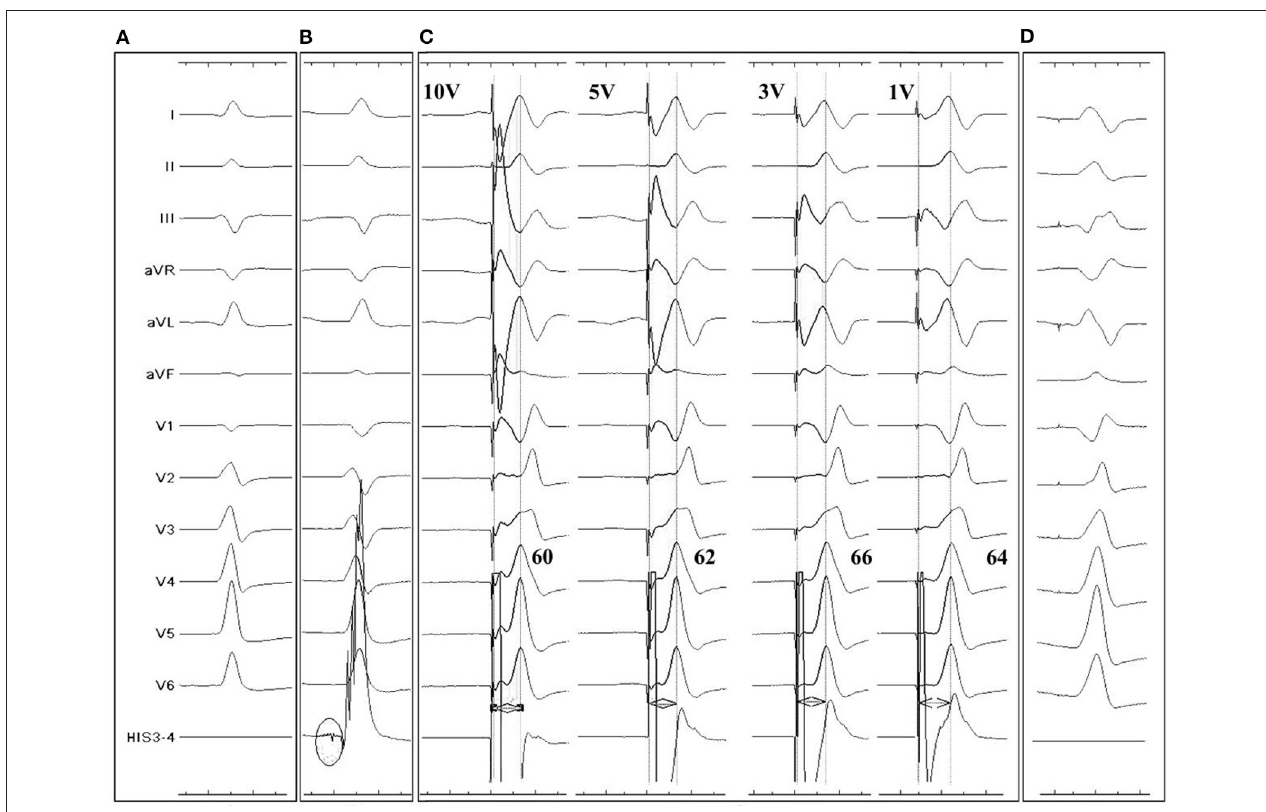
FIGURE 2 | Twelve-lead and intracardiac electrocardiograms (ECG) during LBBP for a 96-year-old III ◦ AVB patient. (A): Intrinsic rhythm showed a QS morphology in V1 lead. (B) LBB potential recorded by pacing tip ( black circle ) when the lead reached LV endocardium. (C) p-LVAT measured by unipolar pacing after fixation. Under different pacing output, QRS showed similar RBB block pattern and p-LVAT stayed short, indicating capture of LBB. (D) Postprocedural ECG recording. A QR pattern was shown in V1 lead. Paced QRS duration was similar to